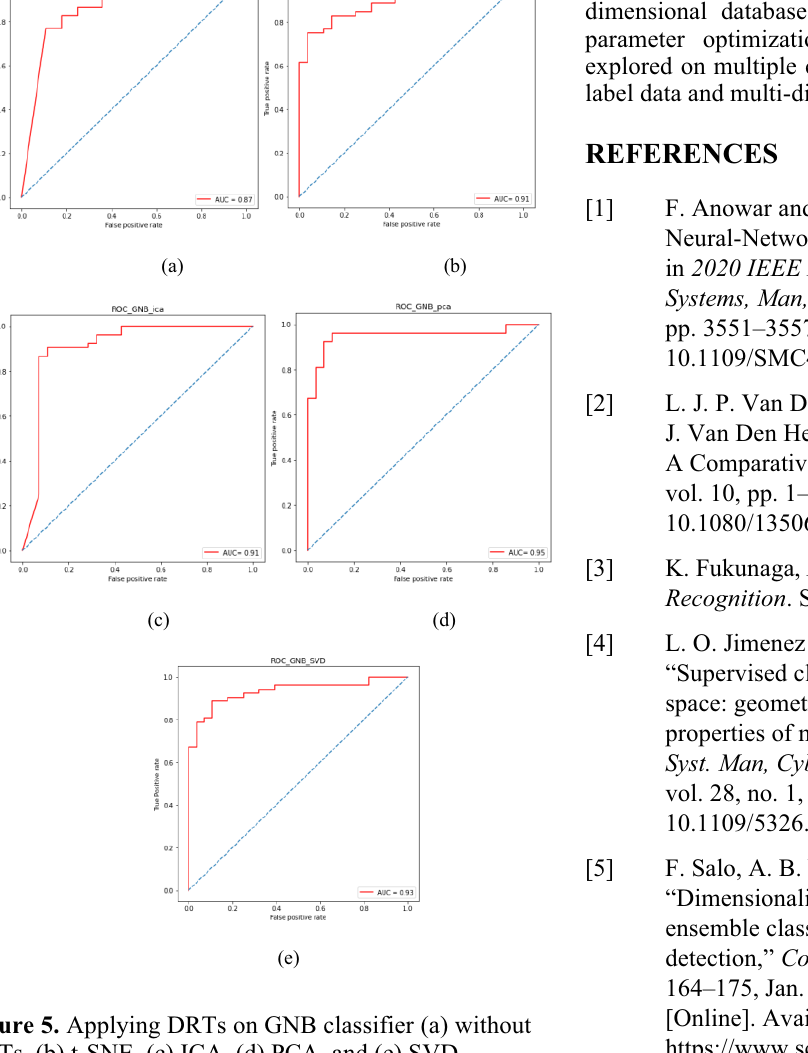
Figure 5. Applying DRTs on GNB classifier (a) without DRTs, (b) t-SNE, (c) ICA, (d) PCA, and (e)